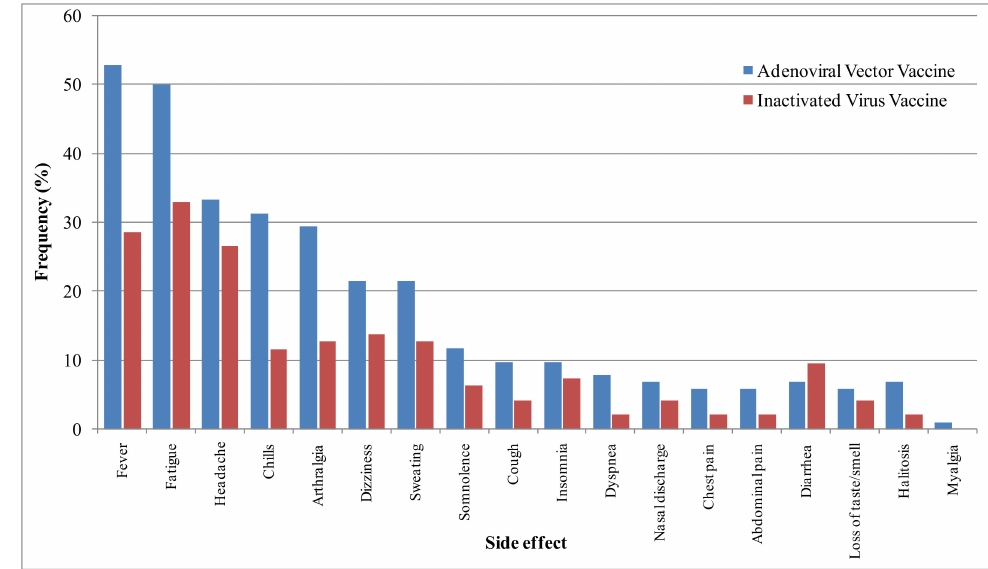
Figure 2. Frequency of systemic side effects of the studied